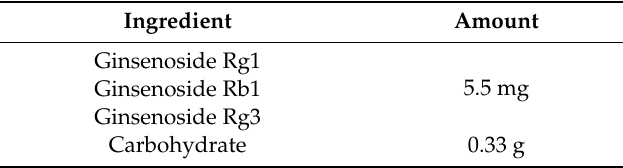
Table 1. Information of the composition of KRG